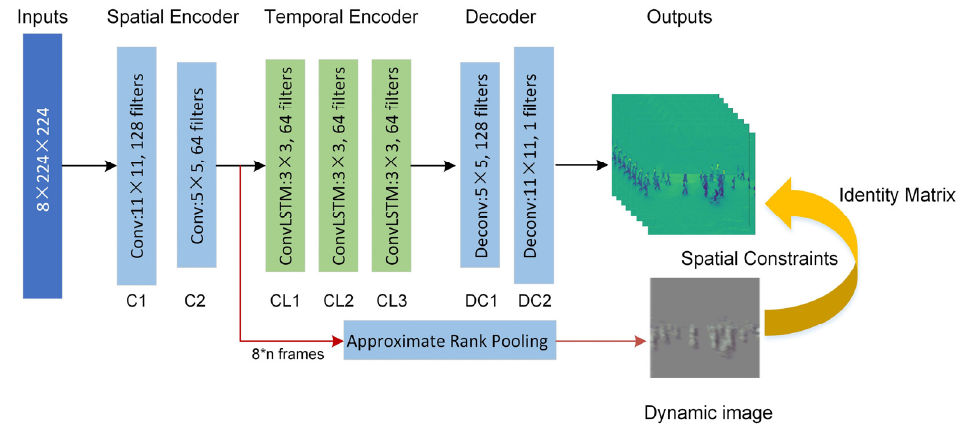
Figure 2. The architecture of the spatiotemporal autoencoder with a dynamic image approximator. The dynamic image presents a spatial rule for the reconstructed images.